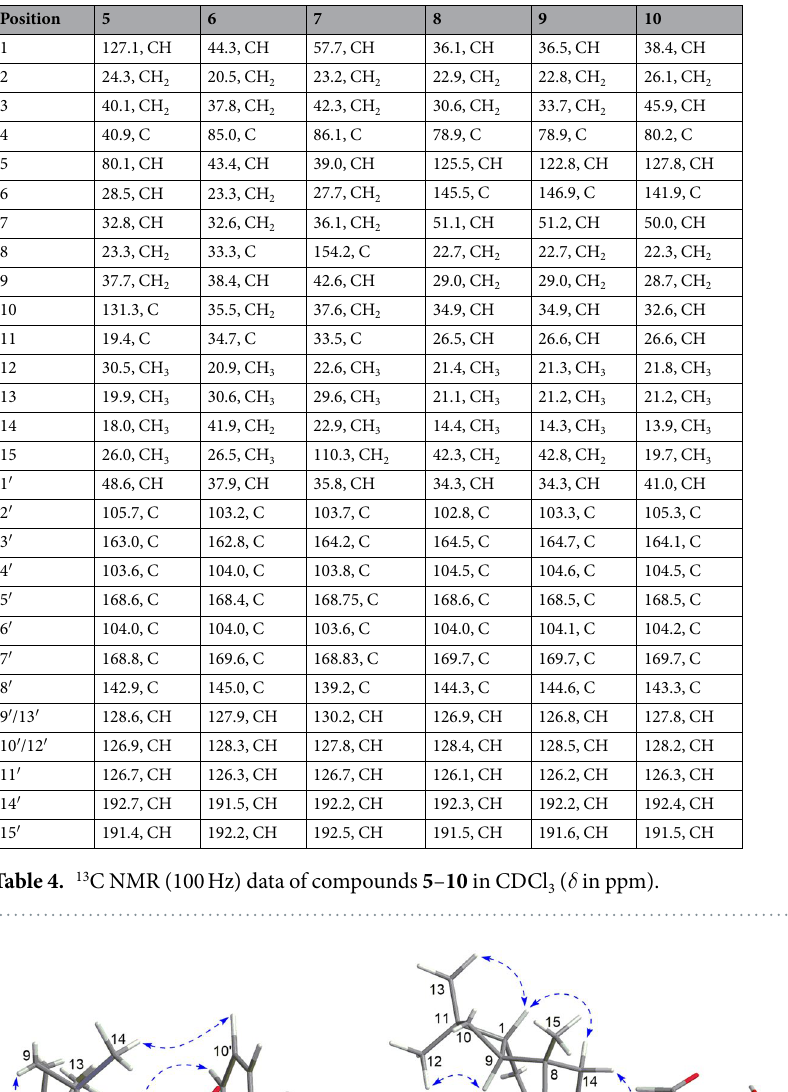
C-3 epimer of 24 , with a trans -fused dihydropyran ring. The R -configuration of C-1 ′ in 10 was established by the Cotton effects at 346 (positive) and 278 nm (positive) in its ECD spectrum (see Supplementary S7.62), which showed the similar tendency to those of 24 . Psiguajadial K ( 11 ) had a molecular formula of C 25 H 25 O 5 as determined by its HR-ESI-MS. The 1D (Table 5) and 2D NMR analysis (Fig. 12) revealed that 11 possessed the same gross structure as that of guadial A ( 26 ) 10 , indicating that they were stereoisomers with configurational variations occurring at the coupling sites. In the NOESY spectrum, the correlations of H-2/H-7 β and H-1 ′ /H-6 β and H-7 α (Fig. 12) indicated that C-1–C-7 bond was β -oriented at the spirocenter while H-1 ′ was α -oriented on the pyran ring. Thus, 11 was established as the